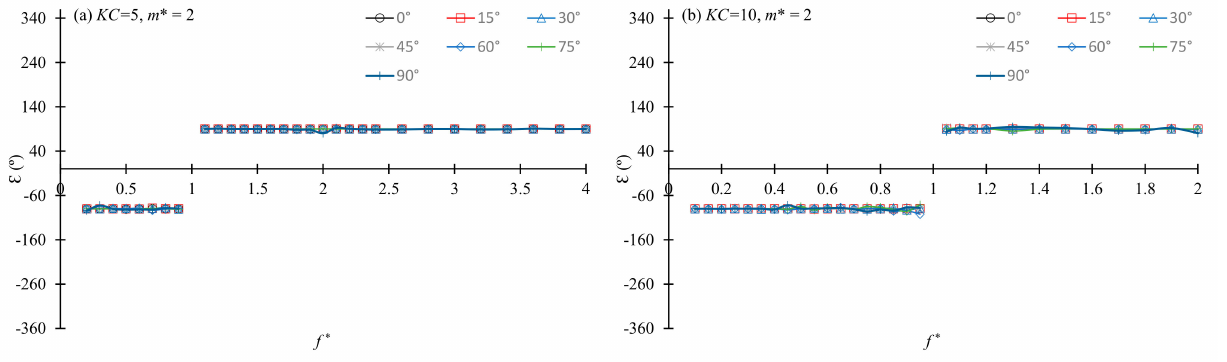
Figure 17. Phase difference between the force and vibration velocity in the x